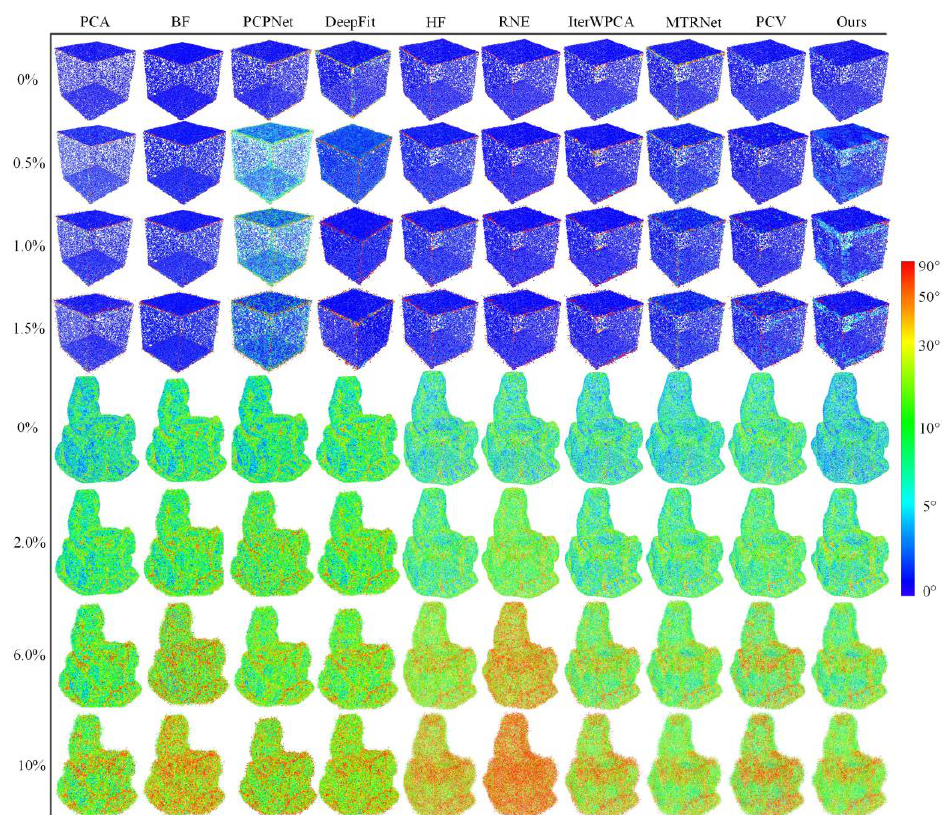
Figure 8. Comparison of the robustness of different algorithms to noise on Cube models with small noise levels and Lagera models with large noise levels.